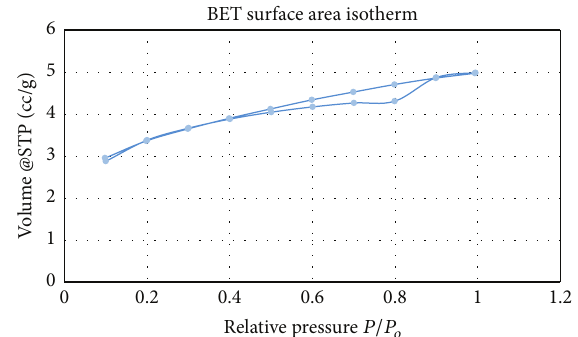
Figure 2: Isotherms of aluminium dross treated with 1% of NaOH at 30 minutes and temperature of 25 ∘ C.